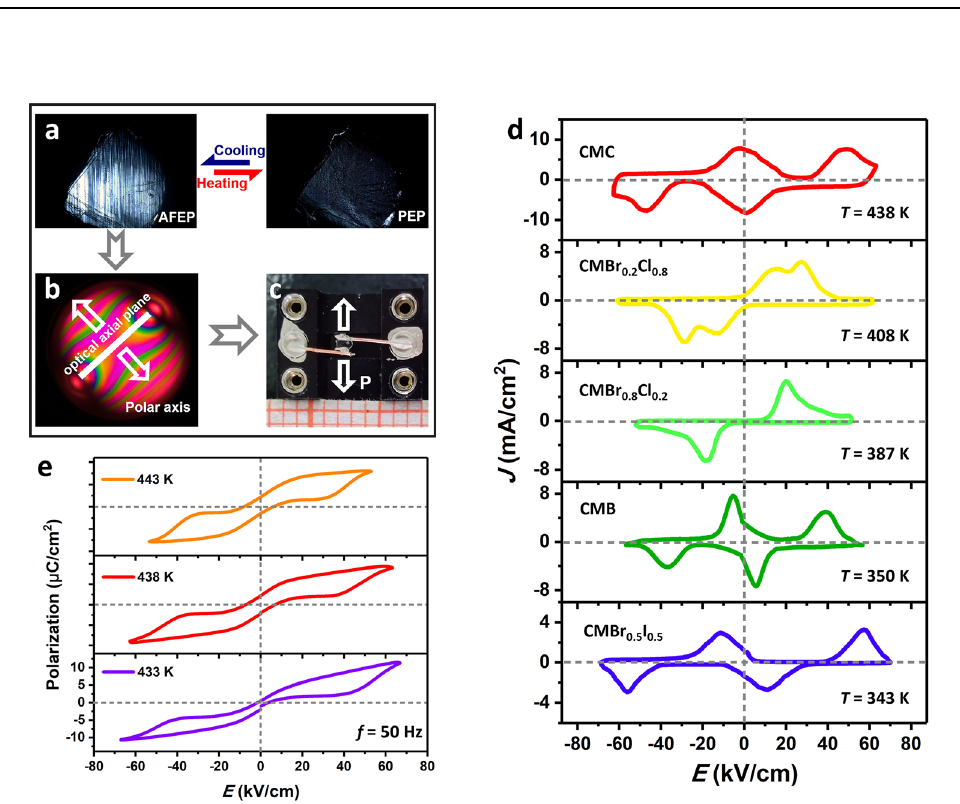
Fig. 3 | CM content-inducedphase transition in solid solutions. a DSCcurves of CMBr x I 1 − x and CMBr x Cl 1 − x solid solutions. b Temperature variation of ε ʹ upon cooling. c Schematic diagram of temperature dependence versus cell lattice parameters obtained directly from the X-ray single-crystal diffraction, as depicted by the short dash lines. d Temperature dependence of ε ʹ and dielectric loss